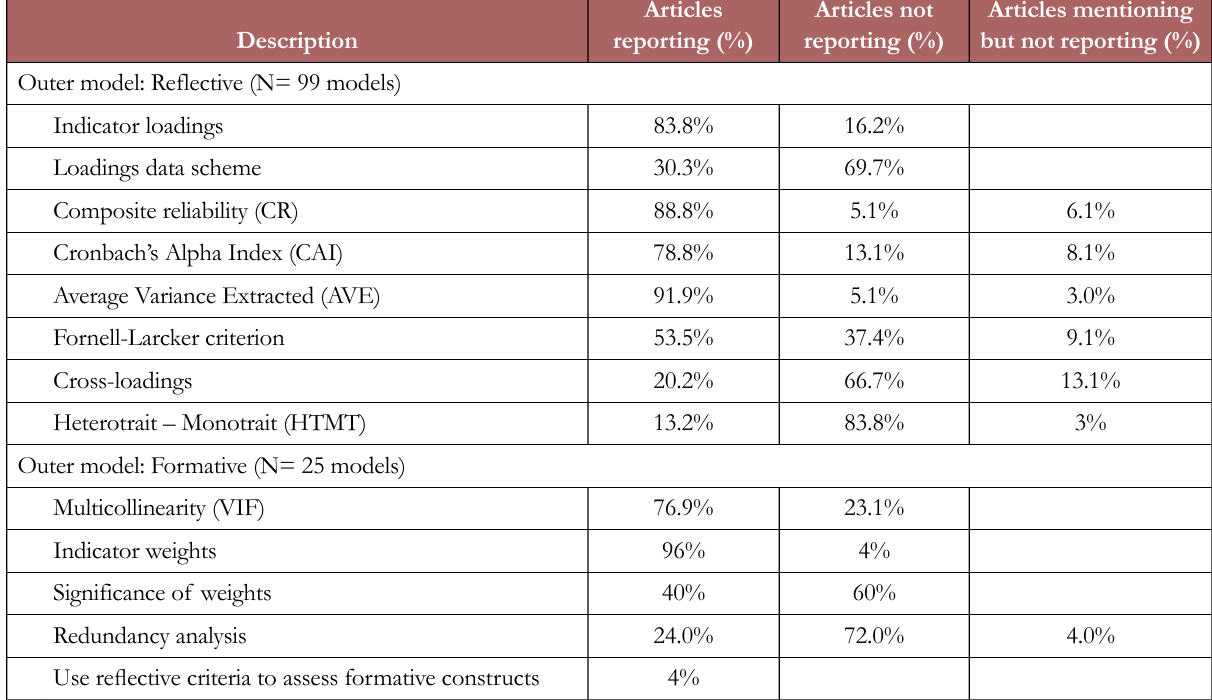
Table 7. Outer model